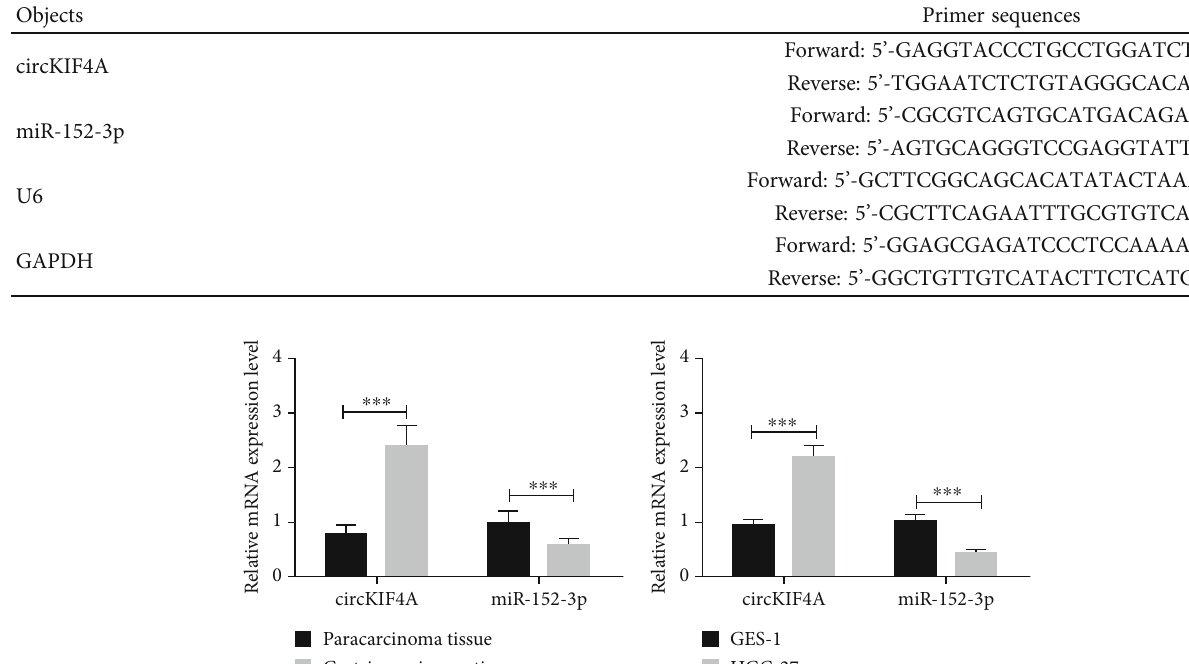
Table 1: Sequences of primers.